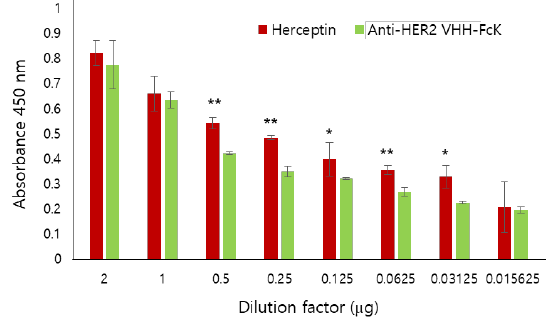
Figure 3. Comparison of the binding activity of Herceptin and the anti-HER2 VHH-FcK P to SK-BR-3 breast cancer cell. Anti-HER2 VHH-FcK and Herceptin, serially diluted from 2 to 0.015625 μg/μL , were applied to ELISA plates seeded with SK-BR-3 cells. We used 1 × PBS as a negative control. The absorbance was measured at 450 nm wavelength. Error bars indicate standard deviation (* p < 0.05, ** p < 0.01).